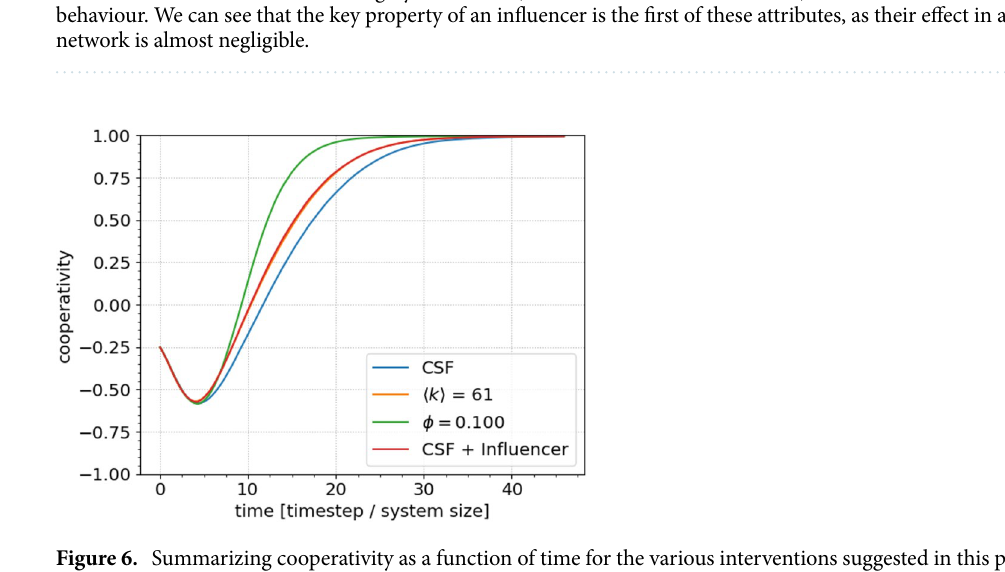
Figure 6. Summarizing cooperativity as a function of time for the various interventions suggested in this paper to increase the rate of convergence towards consensus. Data collected from previously presented figures. The yellow and red curves are overlaid because their impacts are almost